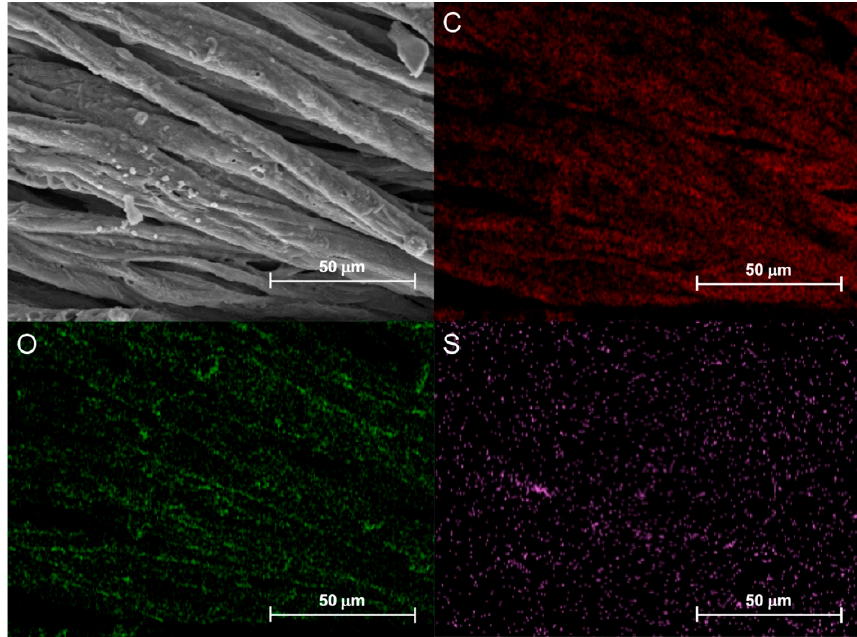
50 –C 50 residue after vertical flame spread tests. Polymers 2019 , 11 , x FOR PEER REVIEW